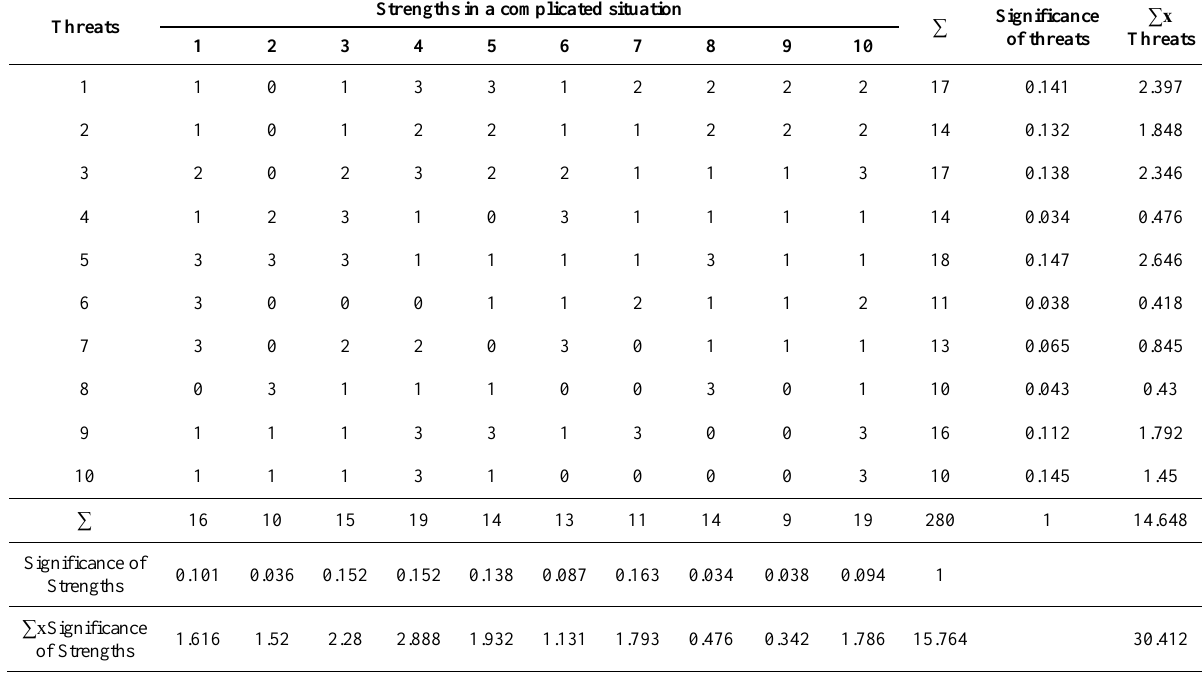
Table 5. Table determining the significance of strengths and